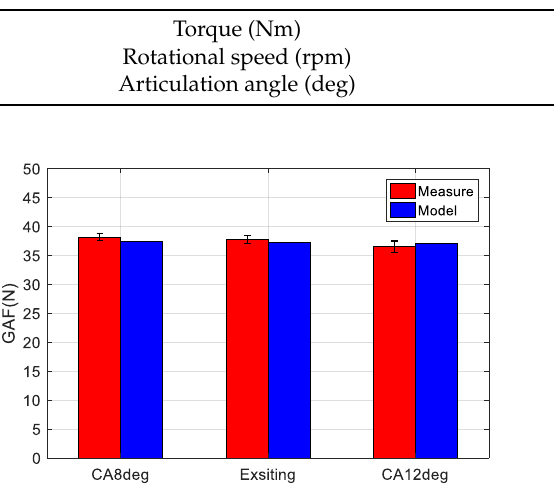
Figure 13. GAF verification results with respect to contact angle.